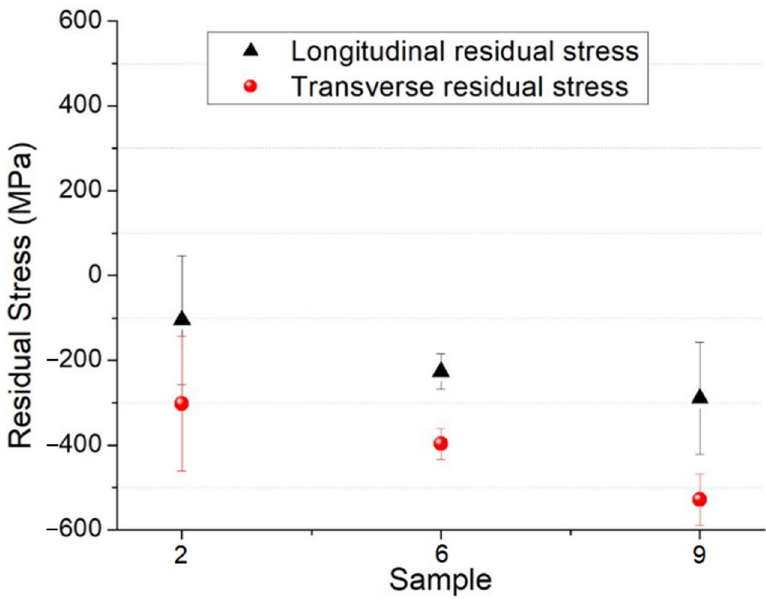
Figure 16. Residual stress values for all the three studied samples.